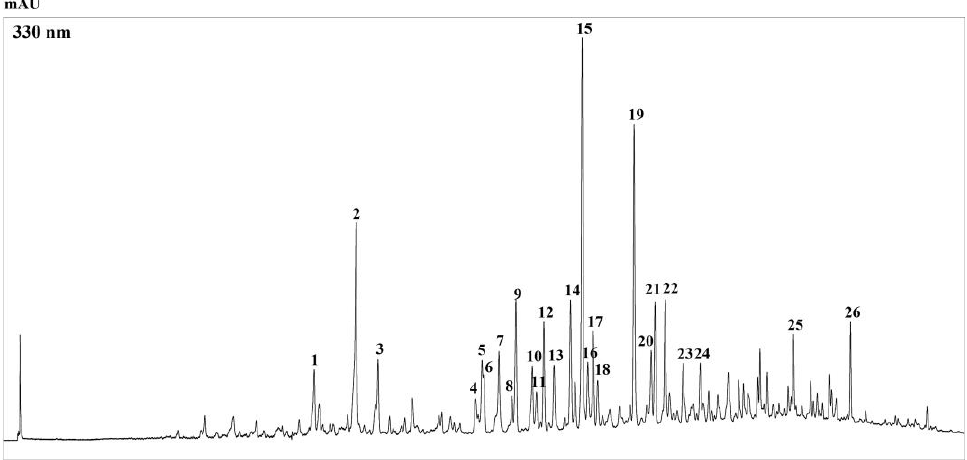
Figure 1. HPLC-PDA chromatograms of the polyphenolic compounds, extracted at 330 nm wave- lenght, of Bff -EAF. For peak identification, see Table 1. Table 1. HPLC-PDA/ESI-MS (negative ionization mode) polyphenolic fingerprint of Bff -EAF. Re- sults are expressed as µg/g fraction ± SD ( n = 3).